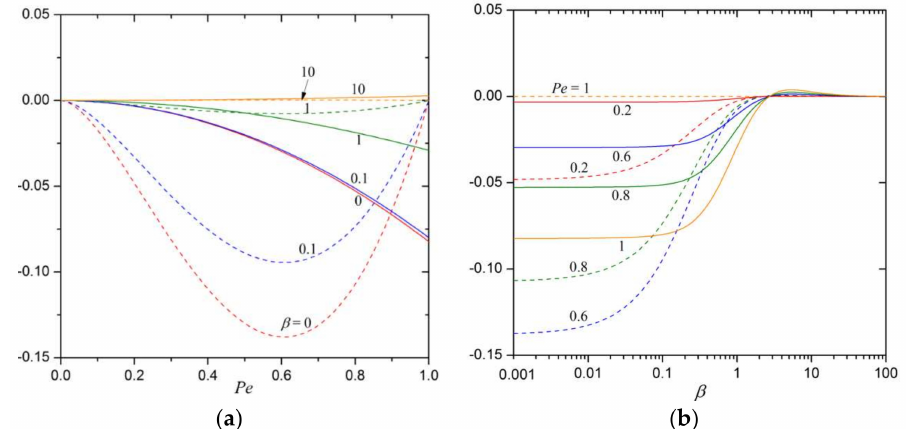
Figure 2. The quantities α 3 Pe 2 ln Pe (in dashed curves) and α 4 Pe 2 (in solid curves) in Equation (20) ( a ) versus the P é clet number Pe for various values of the polarization parameter β ; ( b ) versus β for various values of Pe